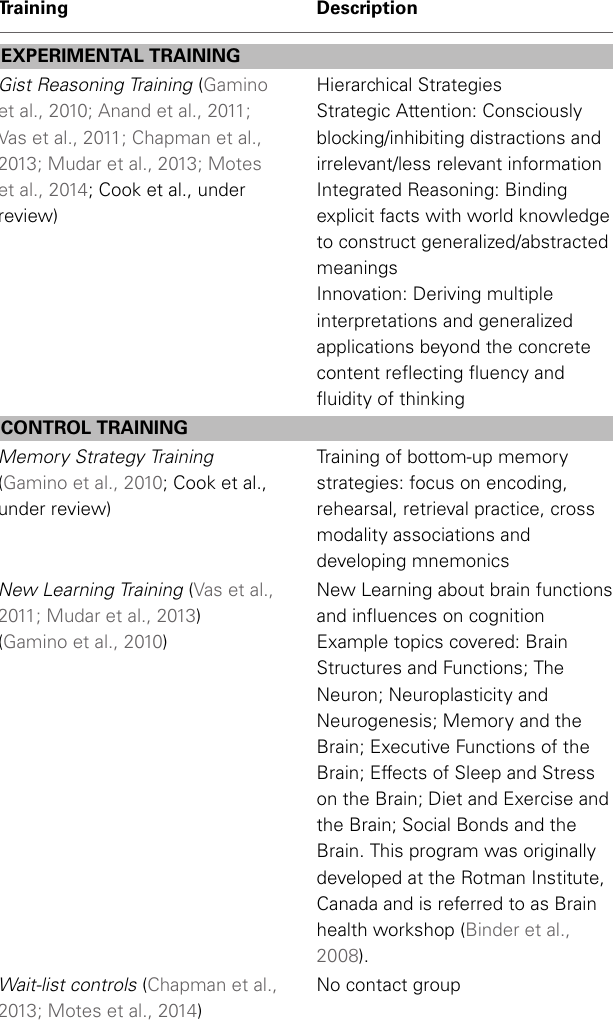
Table 1 | Brief description of experimental and control training